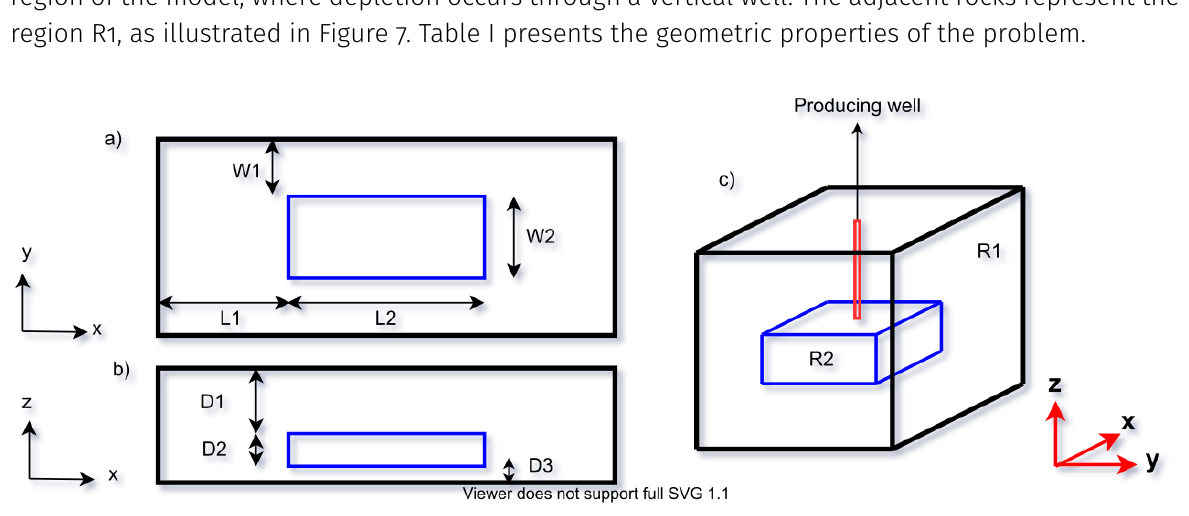
Figure 7. Geometry of problem 3 (Dean et al. 2006). (a) topo view (b) front view and (c) 3d